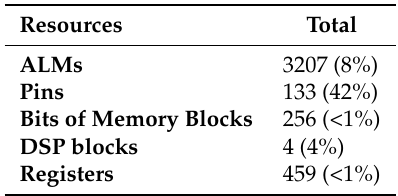
Table 5. Hardware resources used by the DPIM